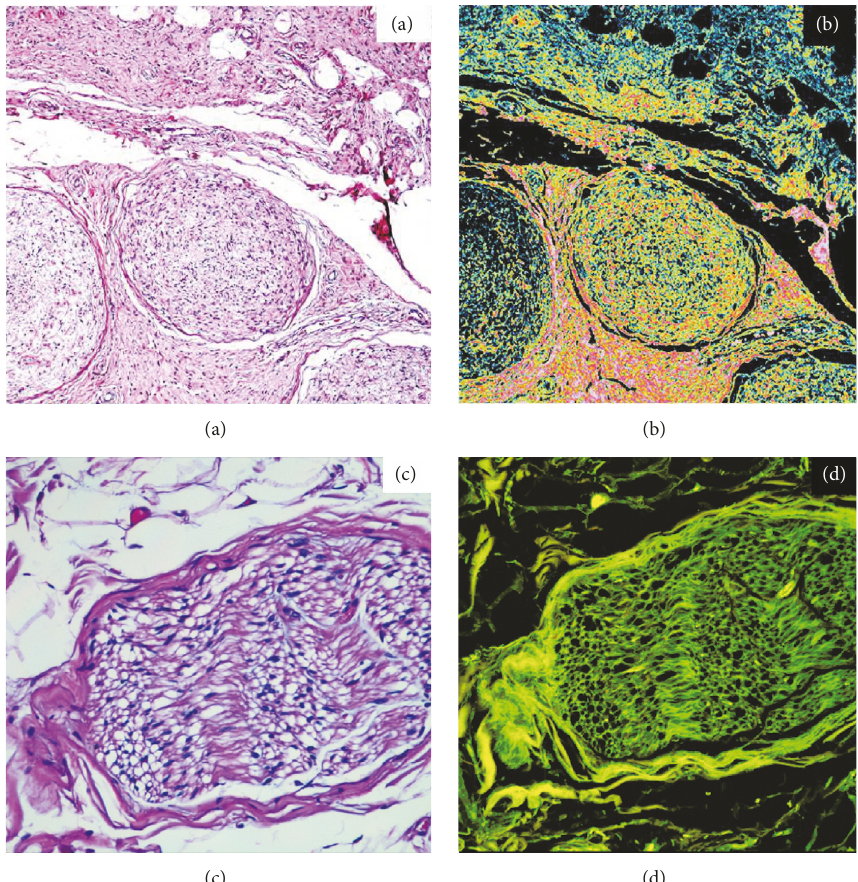
Figure 1: 45X. Traditional optical (a) and confocal laser scanning (b) analyses showing well differentiated Schwann cells in a multinodular plexiform neurofibroma and their intense fluorescence. Fields (c) and (d) show a normal nerve as comparison, respectively, in traditional optic and confocal laser scanning. A normal nerve also shows intense fluorescence.However, several features separate a neurofibroma from a normal nerve: an increase in cell density, an increase in the number of mitosis, and an increase in the number of spindle shaped cells, nuclear anomalies, and the presence of cells of a different nature (such as macrophages, mast cells, and histiocytes).